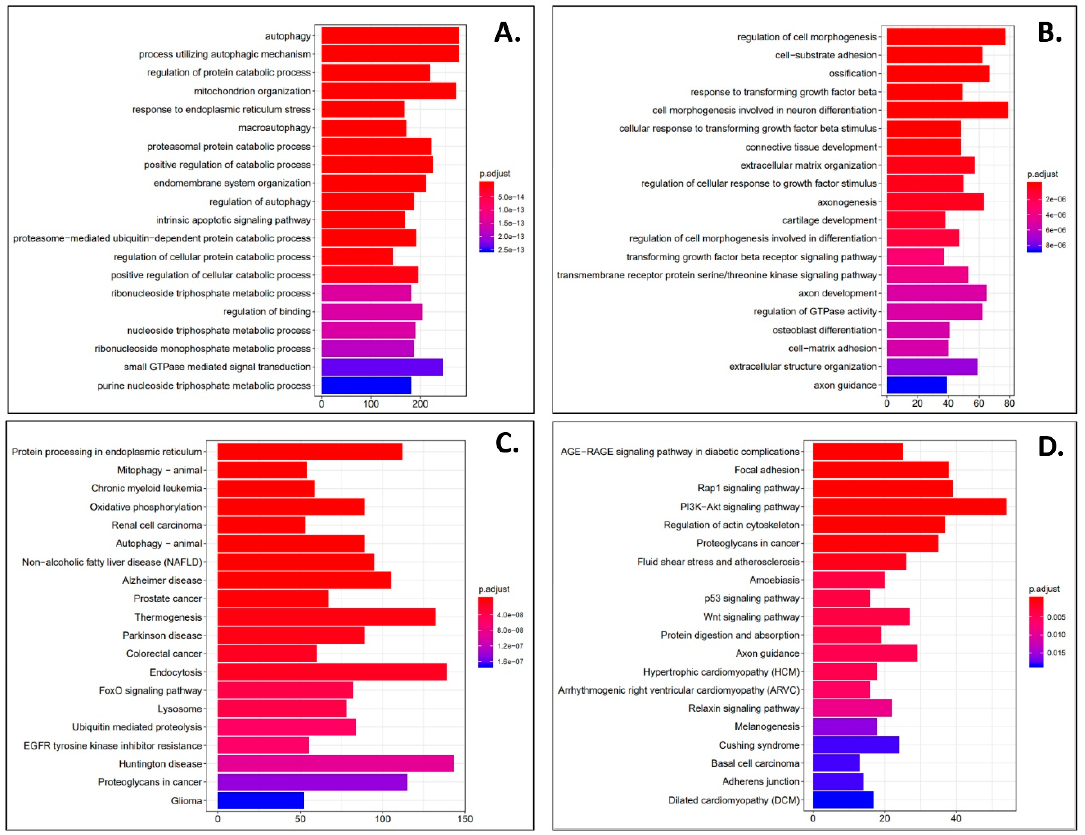
Figure 5. Phenanthriplatin and cisplatin modulate cellular pathways in IMR90 cells. ( A ) The top 20 enriched GO biological processes for the IMR90 phenanthriplatin versus IMR90 control comparison. ( B ) The top 20 enriched GO biological processes for the IMR90 cisplatin versus IMR90 control comparison. ( C ) The top 20 enriched KEGG pathways for the IMR90 phenanthriplatin versus IMR90 control comparison. ( D ) The top 20 enriched KEGG pathways for the IMR90 cisplatin versus IMR90 control comparison. The x -axes show the number of DEGs per GO biological process. Statistical analysis for KEGG pathway analysis is provided in the panels. Table 5. Comparative analysis of gene regulation between phenanthriplatin and cisplatin treatments in A549 and IMR90 cells. Top 10 up-and downregulated DEGs for A549 phenanthriplatin versus A549 cisplatin. DEG data analysis: ( p ≤ 0.05; q ≤ 0.05; log 2 FC ≥ 0; FPKM ≥ 1 in ≥ 3 samples; average